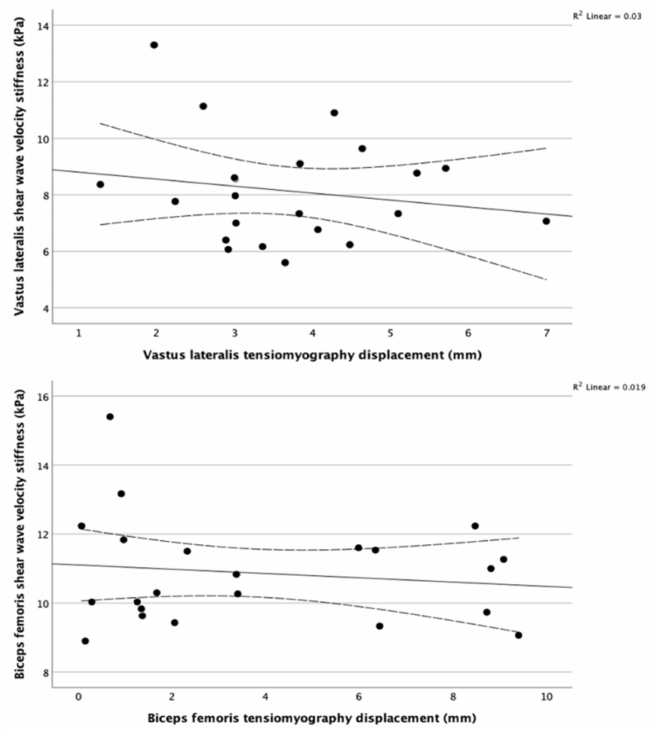
Figure 3. Scatterplots and regression lines for maximum displacement using TMG against shear wave velocity using SWE showing no evident association between them in the vastus lateralis ( top ) and biceps femoris ( bottom ). The dotted lines represent the 95% CI of the mean. The coefficient of determinization in the top right corners confirm the lack of correlation between SWE and TMG for the two